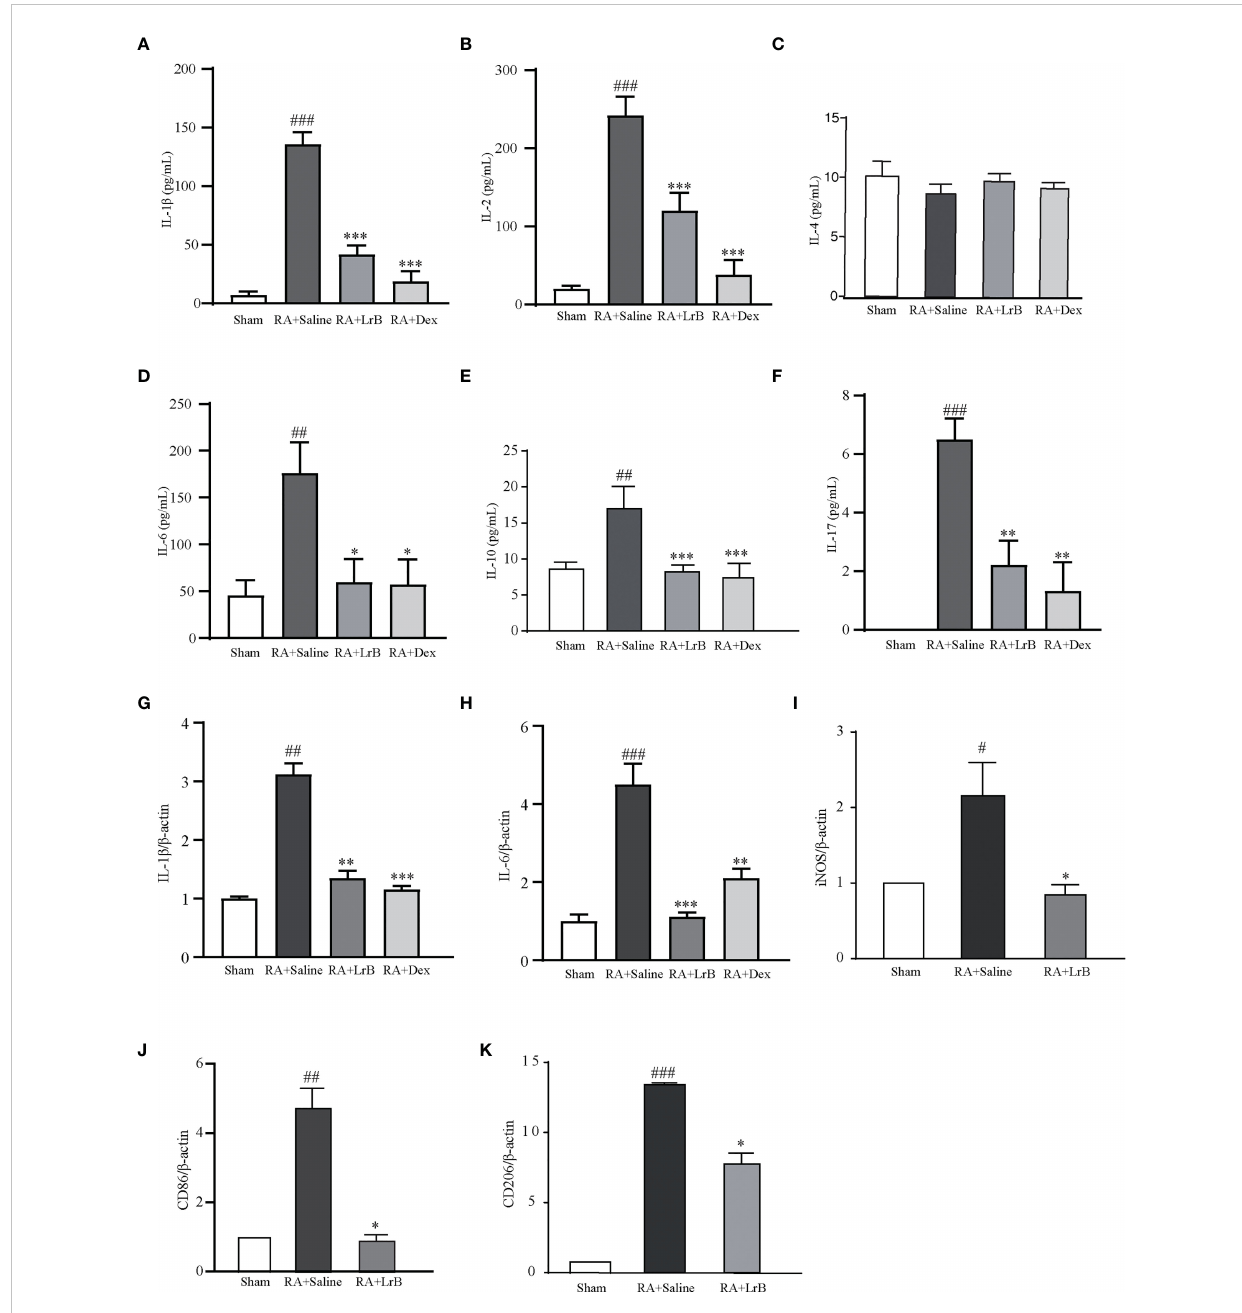
FIGURE 5 LrB decreased cytokine release and Kv1.3 expression in PBMCs from CIA rats. (A) The cytokine IL-1 b concentration in the serum of CIA rats detected by ELISA (n=5). (B) The cytokine IL-2 concentration in the serum of CIA rats detected by ELISA (n=5). (C) The cytokine IL-4 concentration in the serum of CIA rats (n=5). (D) The cytokine IL-6 concentration in the serum of CIA rats (n=5). (E) The cytokine IL-10 concentration in the serum of CIA rats (n=5). (F) The cytokine IL-17concentration in the serum of CIA rats (n=5). (G, H) IL-1 b (G) and IL-6 (H) mRNA in joint cartilage as shown by qPCR (n = 6). (I – K) iNOS (I) , CD86 (J) , CD206 (K) mRNA in spleen cells as shown by qPCR (n=4). (Results are expressed as the mean ± SEM, and tested with One Way ANOVA. #, P ≤ 0.05, ##, P ≤ 0.01, ###, P ≤ 0.001, compared to the Sham group; * P ≤ 0.05, * * P ≤ 0.01, * * * P ≤ 0.001, compared to the RA+Saline